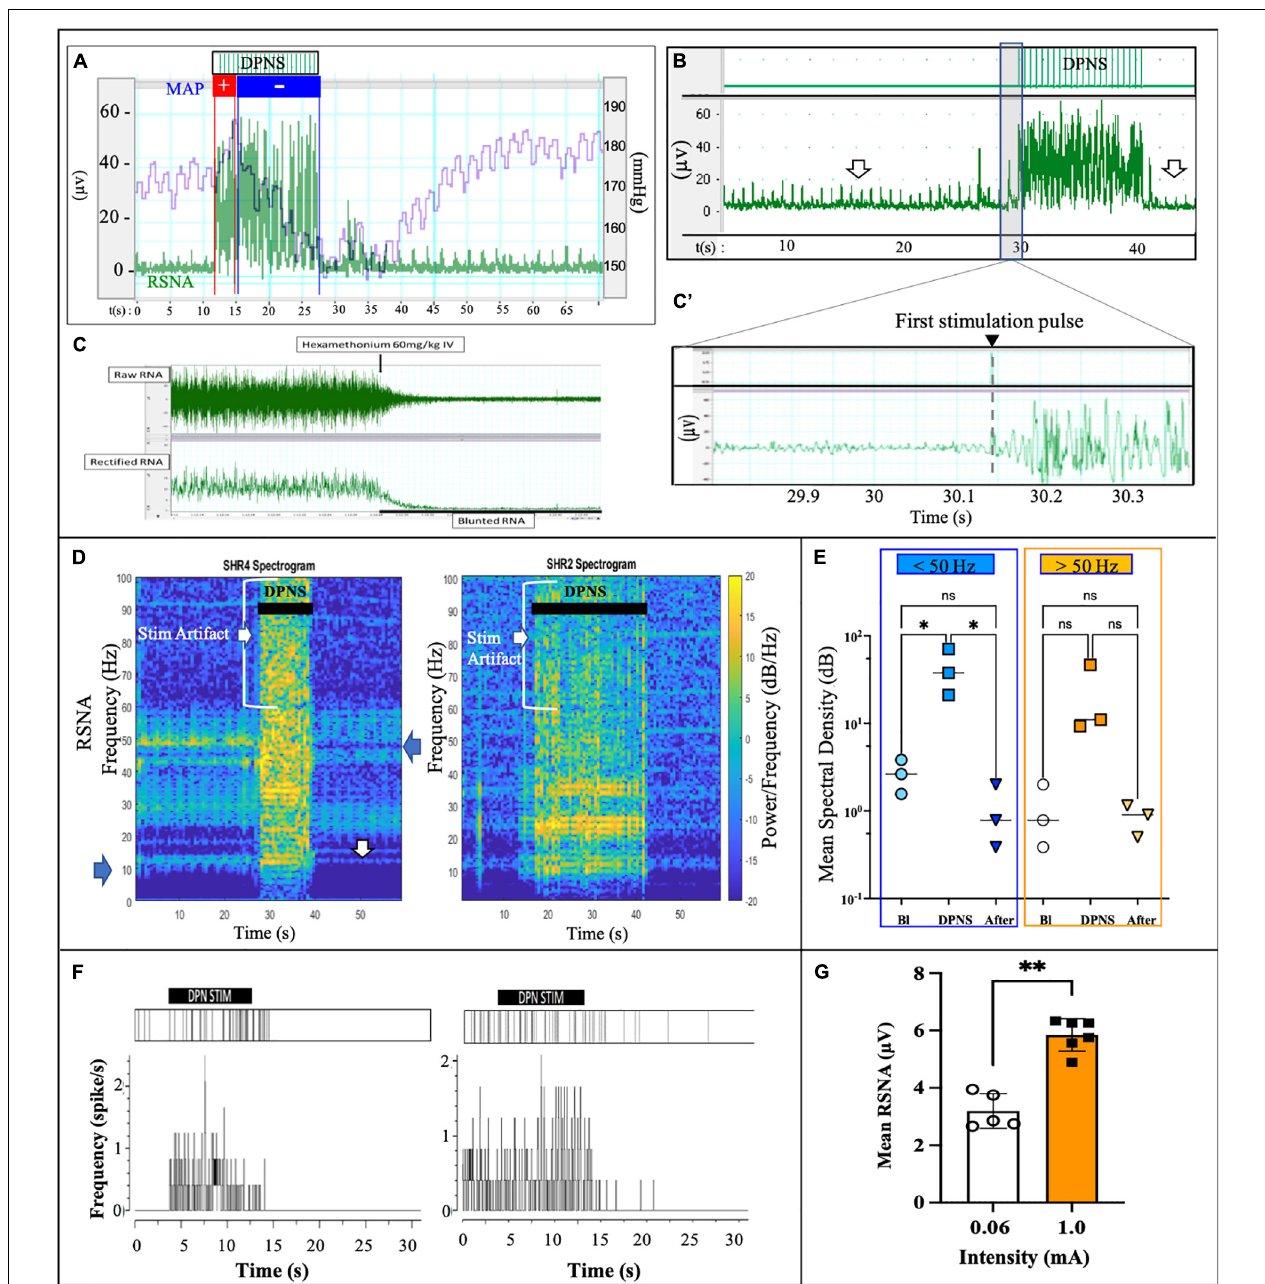
FIGURE 3 | DPNS neuromodulation of RSN activity. (A) Spontaneous RSNA (green) increased in amplitude and frequency during the 10 s DPNS. Concurrently, the MAP decreases (blue). (B,B’) The onset of RSNA was observed at approximately 0.2 s after the first DPNS stimulation pulse. Arrows point before and after RSNA, to highlight the decrease in amplitude. (C) Nicotinic receptor blocker hexamethonium (60 mg/kg) confirmed RSNA activity. (D) Power spectral analysis in two different SHR animals after 10 and 20 s of DPNS showed the RSNA band at 10–50 Hz; arrows point signals and stimulus artifact. (E) Compared to baseline (Bl), the mean SSD showed a significant increase in the RSNA range (ANOVA * p < 0.05, n = 3), but not 10 s after stimulation. (F) Raster plots of two waveforms from RSNA, one was evoked during the stimulation and the second was present before stimulation and reduced thereafter. (G) 1 mA stimulation pulses increased the amplitude of the evoked RSNA (** p < 0.004, paired t -test, n = 5). ES, electrical stimulation; DPN, deep peroneal nerve; DPNS, deep peroneal nerve stimulation; RSNA, renal sympathetic nerve activity. RF antenna. Threshold limb activity was observed at 20% of power and the maximal response at 40%, with magnetic fields below the 1.6 W/Kg SAR